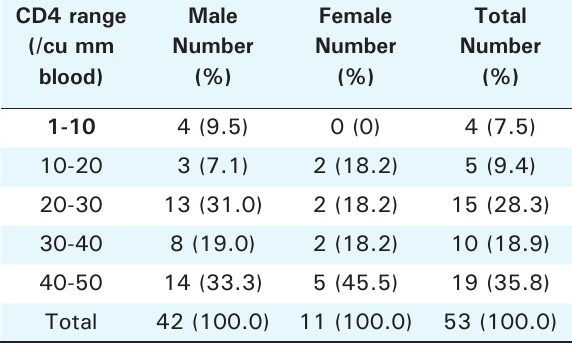
table 2. Distribution of HIV patients by cD4